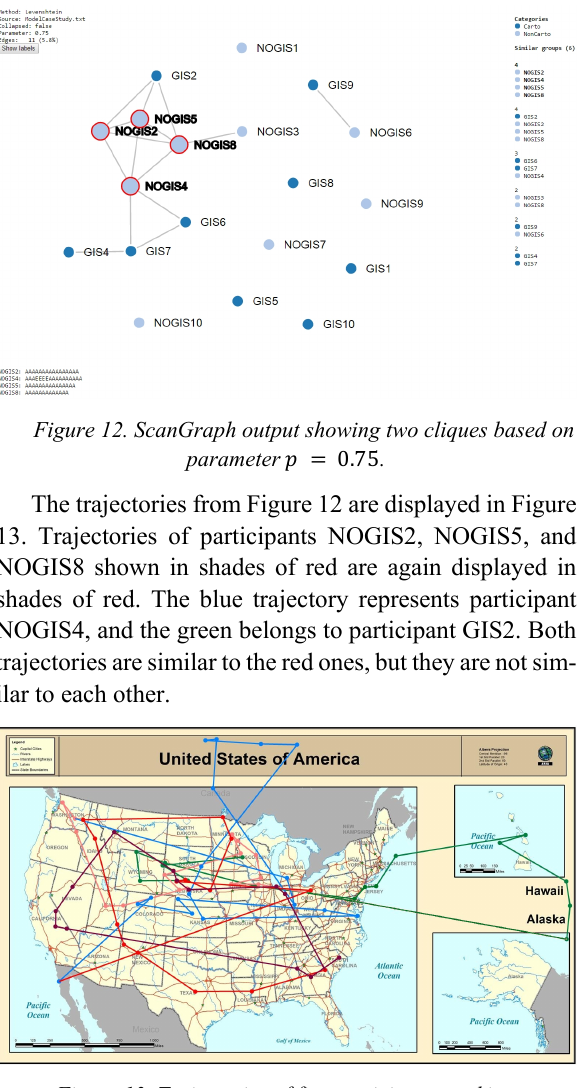
Figure 13. Trajectories of five participants making two cliques (based on parameter (cid:1868) (cid:3404) 0.75 ). Participants NOGIS2, NOGIS5, and NOGIS8 are displayed in shades of red. Partici- pants NOGIS4 (blue line) and GIS2 (green line) are both simi- lar to the red ones, but not to each